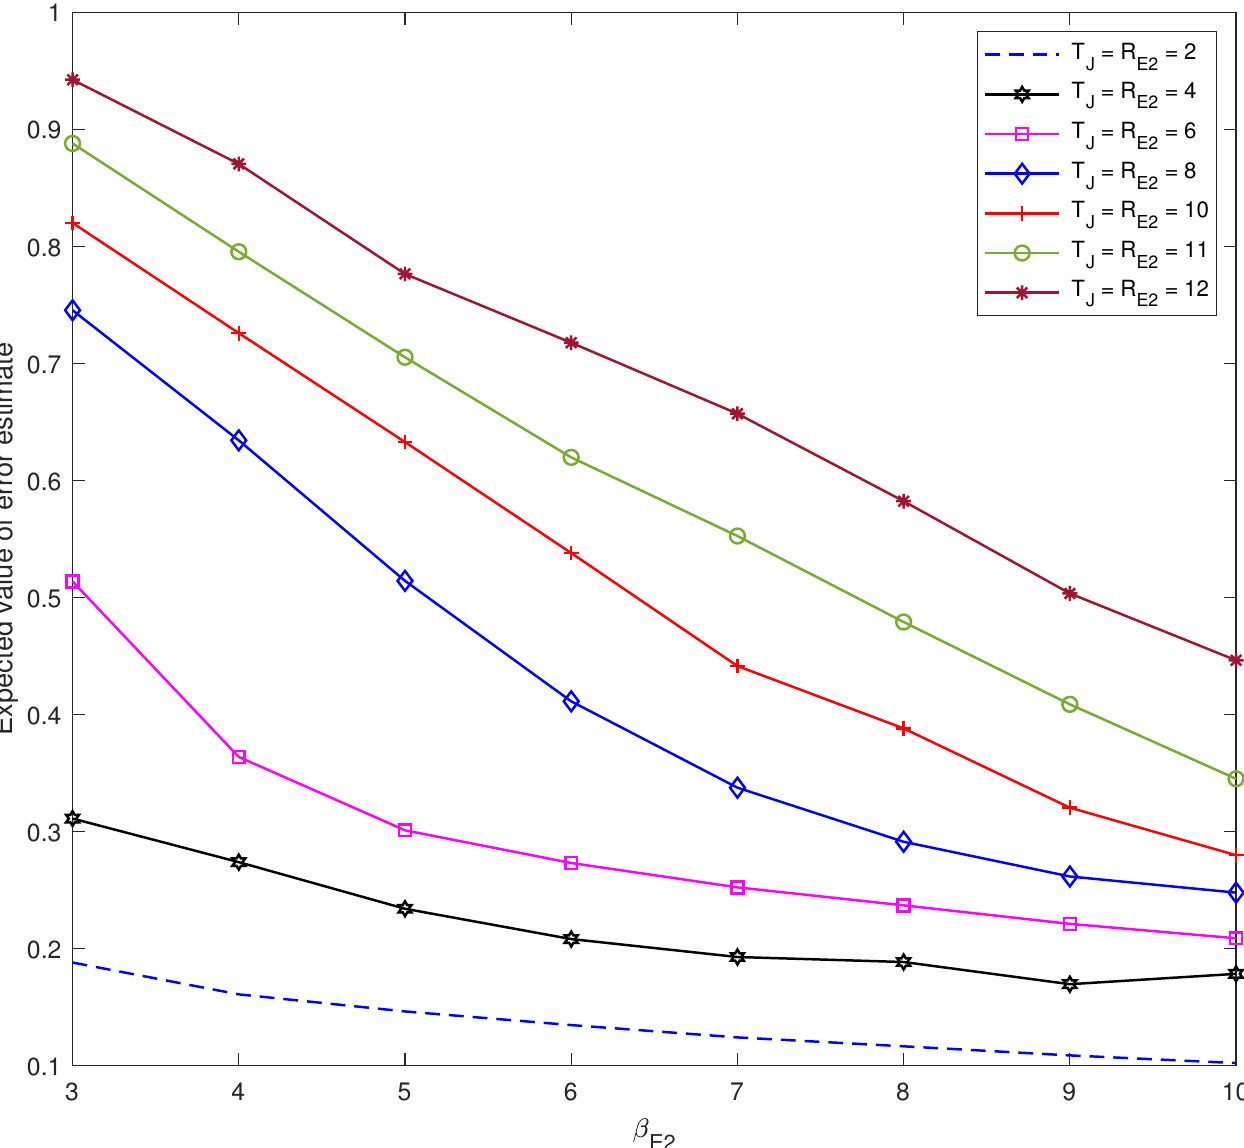
Figure 4. The expected jamming signal estimate error at E2 with the feedback of information signal estimate, where T J = R E 2